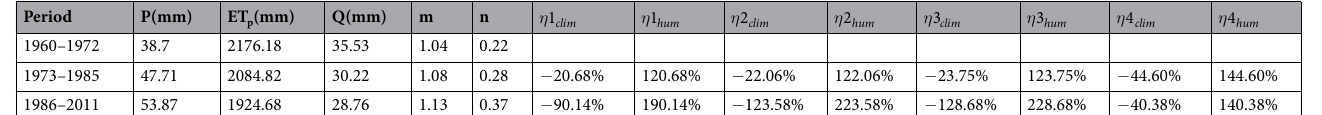
Table 3. Contributions of climate variability and human activities on streamflow alterations. Note: η 1 η 3 , η 4 are the contribution rates of climate change in Budyko, Fu., Choudhury equations and DMC, clim clim respectively. η 1 , η 2 , η 3 , η 4 are the contribution rates of human activities in Budyko, Fu., Choudhury hum hum hum hum equations and DMC, respectively.